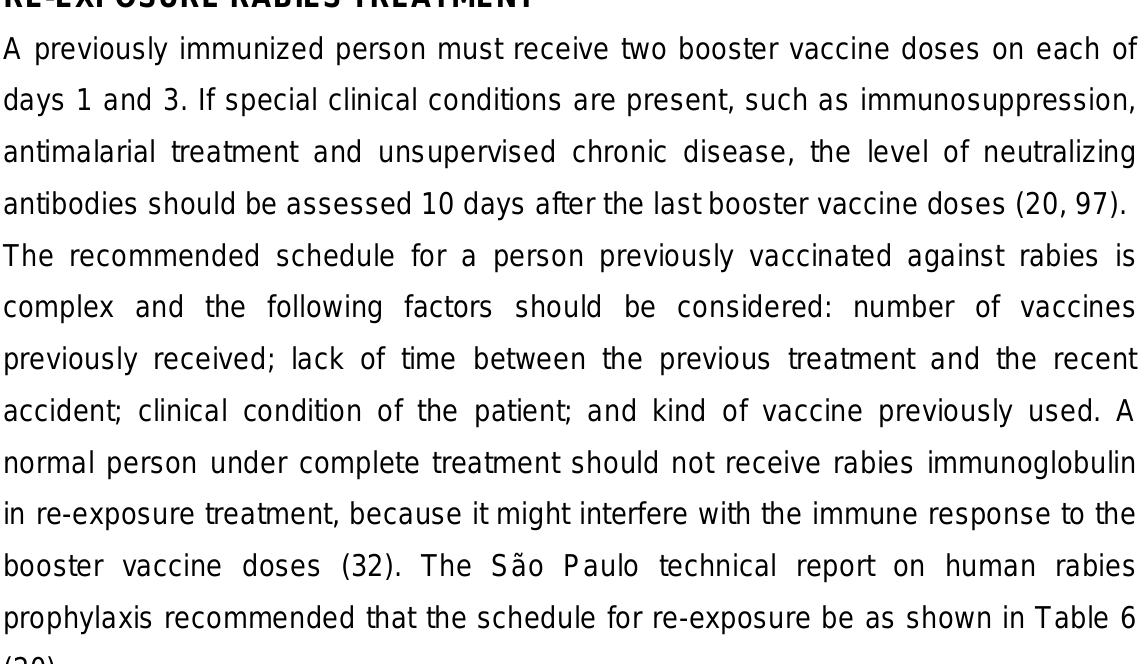
Table 6: Re-exposure rabies treatment. TIME AFTER PREVIOUS SCHEDULE RECOMMENDED VACCINATION Less than 15 days Complete Incomplete Between 15 and 90 days Complete Incomplete - 1 or 2 doses Incomplete - 3 or 4 doses After 90 days Complete Incomplete Source: Costa et al. , 1999